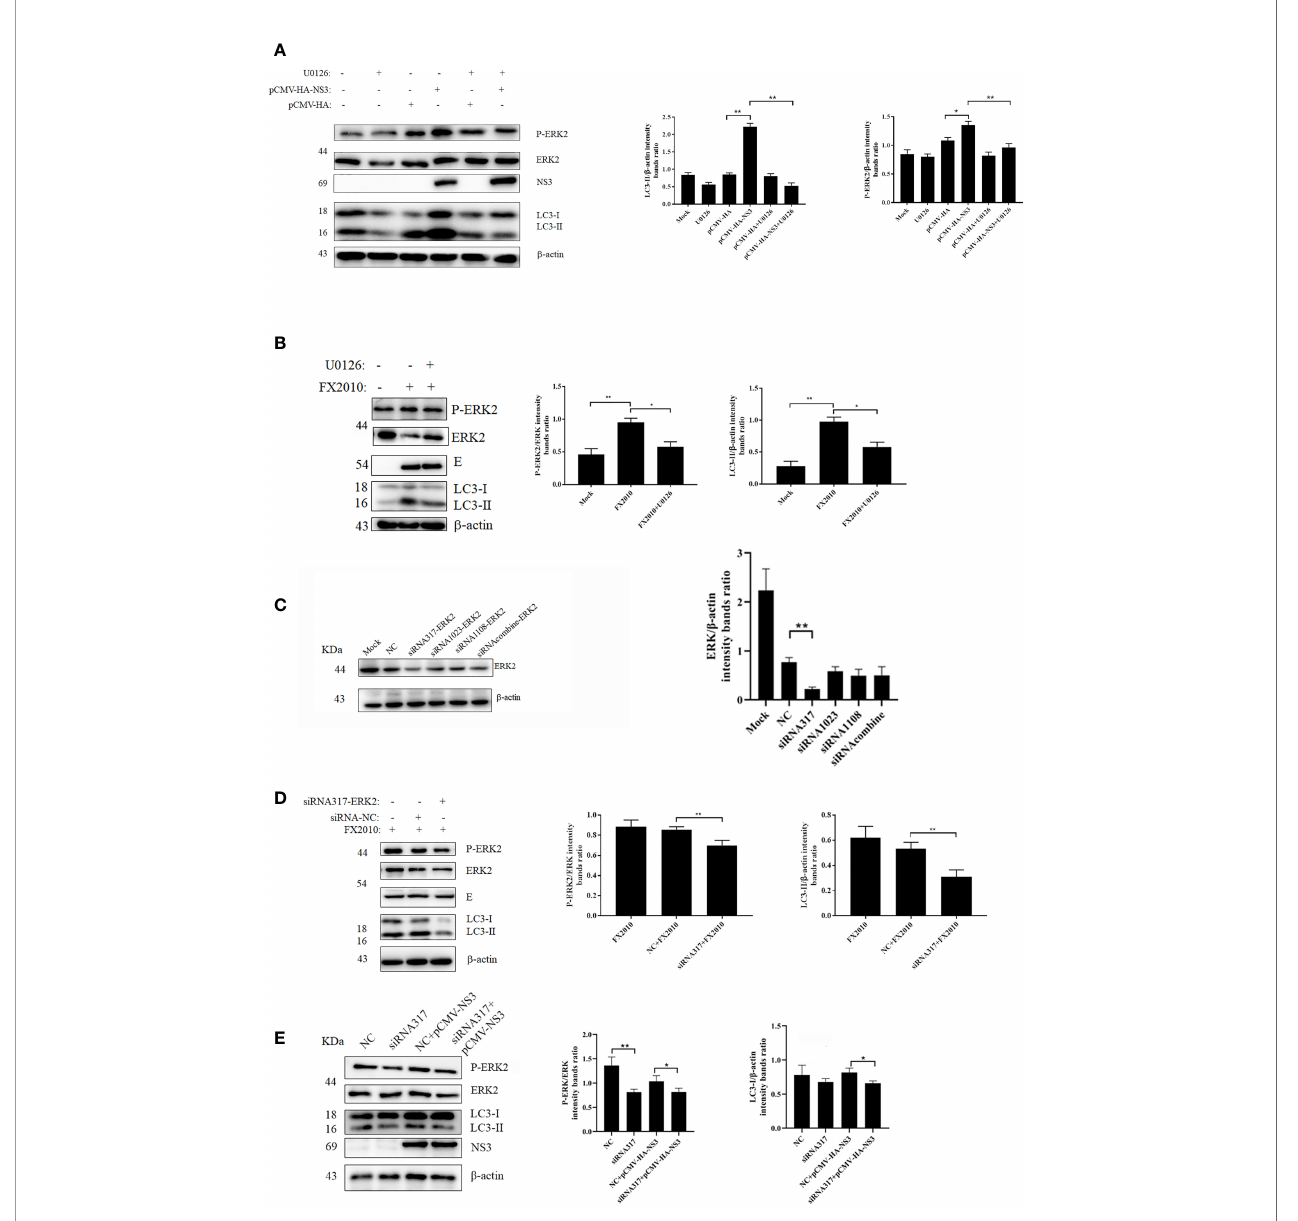
FIGURE 3 | NS3-induced autophagy by promoting the phosphorylation of ERK. (A) After 2 h of treatment with U0126 (20 m M), the pCMV-HA and pCMV-HA-NS3 plasmid was transfected into DEF cells respectively, and samples were collected at 24 hpt. (B) DEF cells infected with MOI = 0.1 virus for 24 h. (C) DEF cells were transfected with three siRNAs for ERK2 and negative control siRNA for 24 h, after which the samples were used for Western blot analysis. (D) After the transfection of siRNA or NC into DEF cells for 24 h, cells were infected with MOI = 0.1 virus. After 24 h, the samples were collected for autophagy analysis. (E) After the transfection of siRNA or negative control into DEF cells for 24 h, the pCMV-HA-NS3 plasmid was transfected. After 24 h, the samples were collected for autophagy analysis. The density of the protein bands measured with fusion analysis in ImageJ software was determined after subtracting the density of the b -actin bands. The b -actin protein was used as the internal control. Data (M ± SD of technical triplicates) represent three independent experiments or are pooled from three independent experiments (M ± SD). * p < 0. 05; ** p < 0.